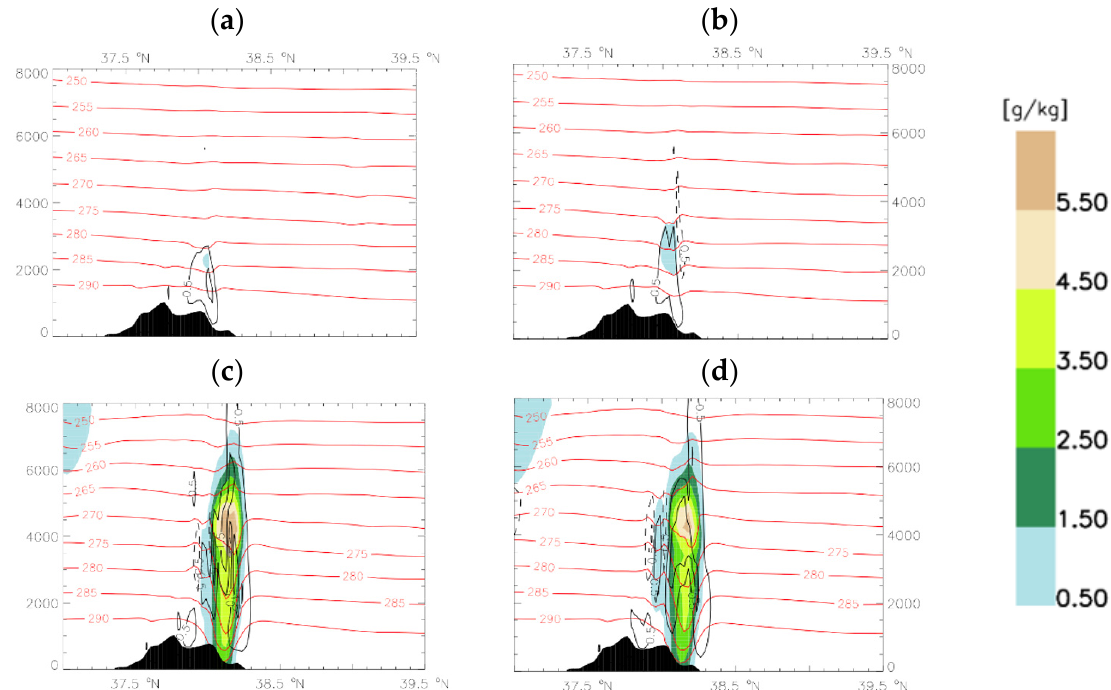
Figure 10. Latitude–height cross sections (13.38 ◦ E longitude, i.e., corresponding to Palermo’s urban area) of total condensate (filled contours, g/kg), temperature (red contours, K) and vertical velocity (black contours, solid for updrafts and dashed for downdrafts, m/s) for ( a ) CTRL; ( b ) RAD; ( c ) LIGHT; ( d ) RL. All panels are at 14:30 UTC.